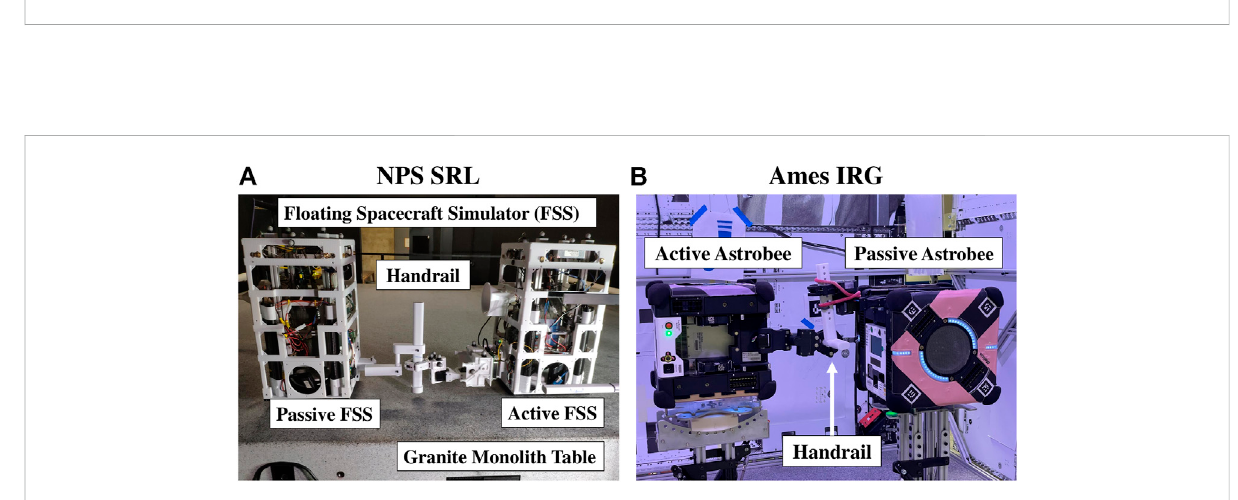
FIGURE 3 Experiment ground testing set up: (A) at NPS SRL and (B) at NASA Ames IRG (credit NASA).